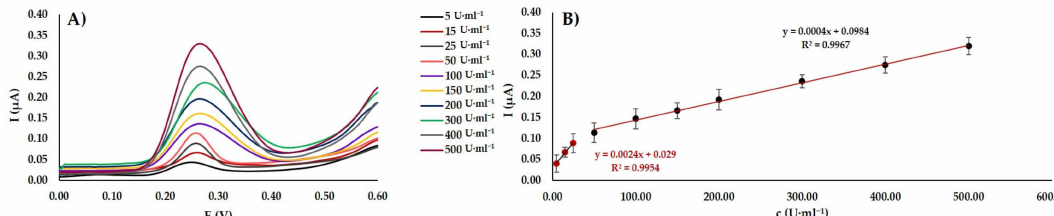
Figure 5. Monitoring of methyltransferase activity by di ff erential pulse voltammetry